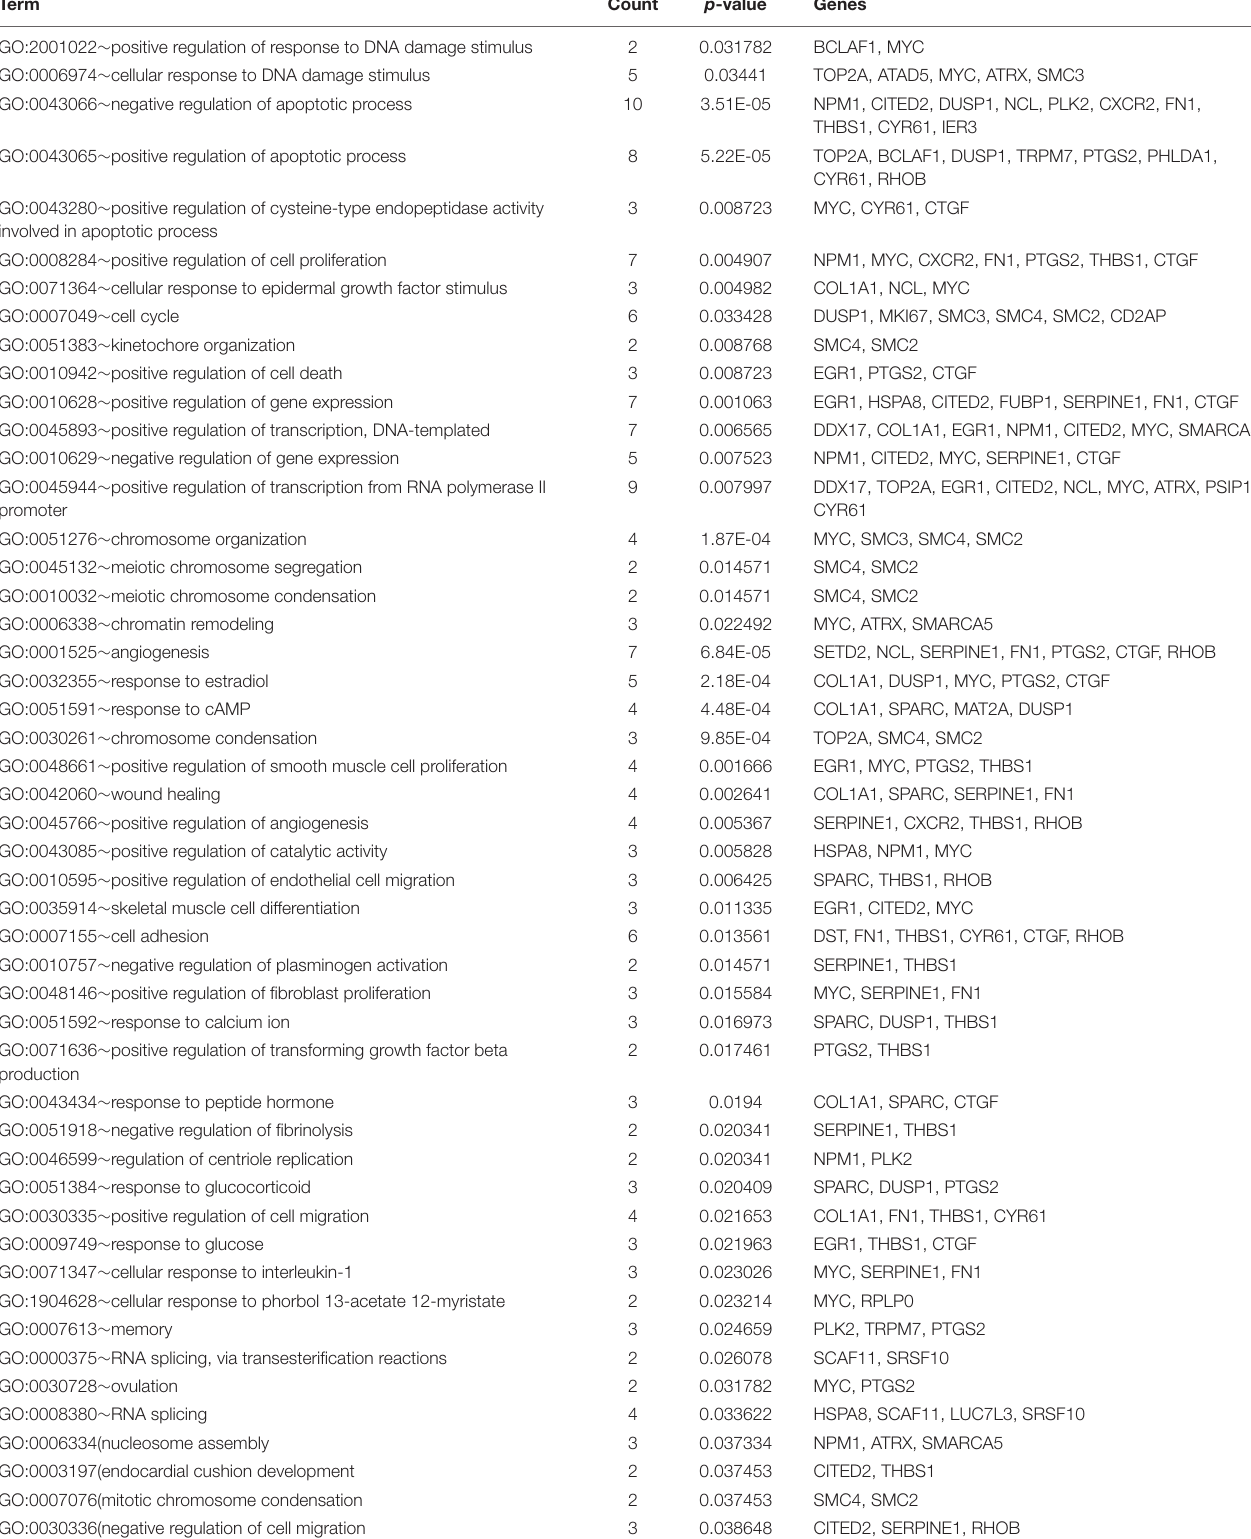
TABLE 5 | Gene ontology enrichment analysis on GC-1 and TM4 common deregulated genes. Term Count p -value